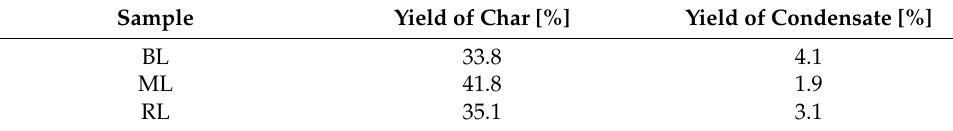
Table 3. Yield of chars and condensates obtained during pyrolysis of samples.